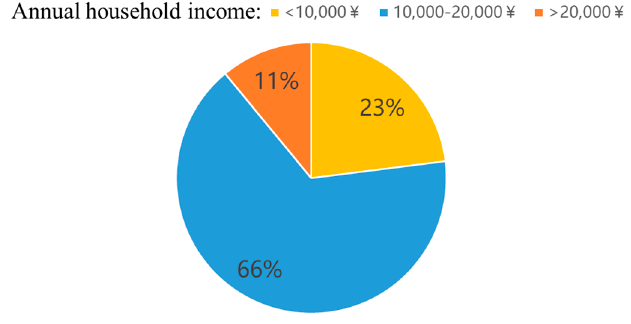
Figure 13. Distribution proportion of annual household income.